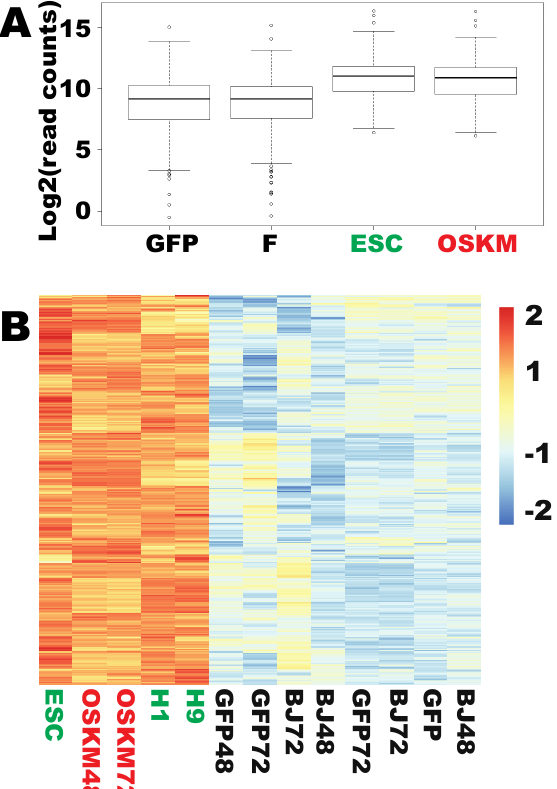
Figure 1. Three hundred sixty-six pluripotency-enriched genes were successfully upreprogrammed to the levels found in human ESCs. ( A ) A box plot for overall successful upreprogramming of the 366 genes at the transcriptional levels. Dots above or beneath the wiskers are outliers of each group. ( B ) A heat map showing successful individual upreprogramming of the 366 PSC genes. ESC: human embryonic stem cells ( n = 3); H1: ESC cell line H1; H9: ESC cell line H9; OSKM: OCT4, SOX2, KLF4, and c-MYC; F: fibroblasts; BJ: human fibroblasts ( n = 4); GFP: human fibroblasts transduced with lentiviral GFP ( n = 4). Numbers in each label are the period of time for which transgenes had been introduced into the fibroblasts. Log2-transformed read counts were used to prepare box plots and heat maps. Heat maps were scaled by rows or genes.